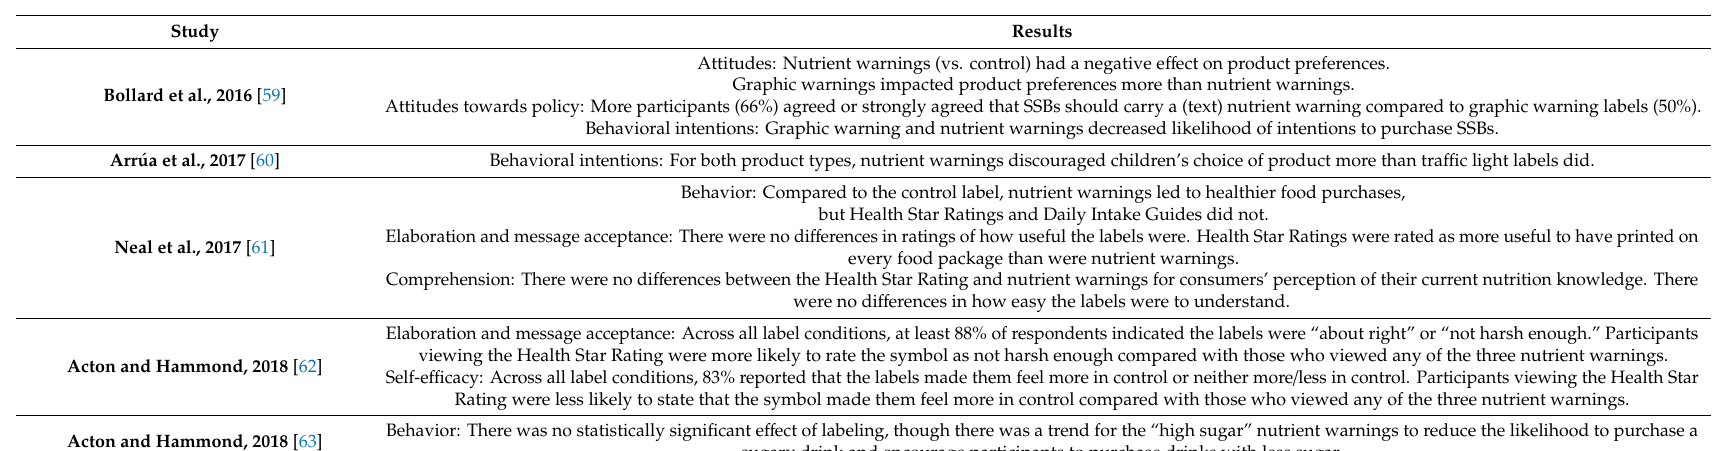
Table 3. Summary of study